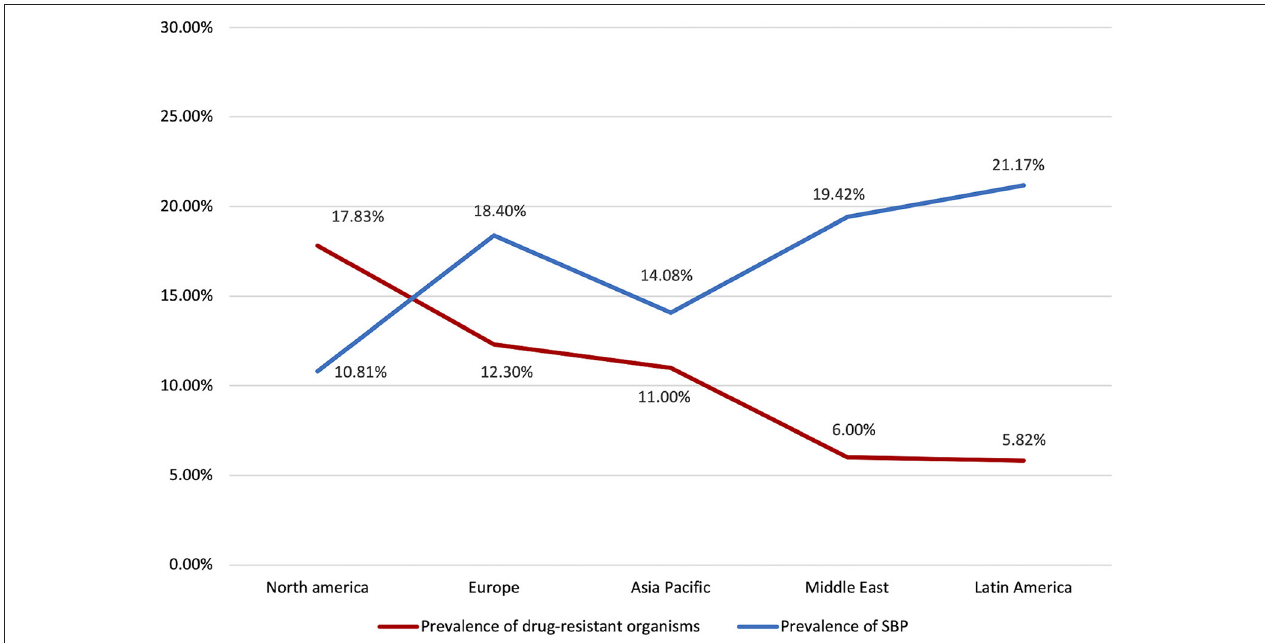
FIGURE 4 | Prevalence of SBP and drug resistance by region.